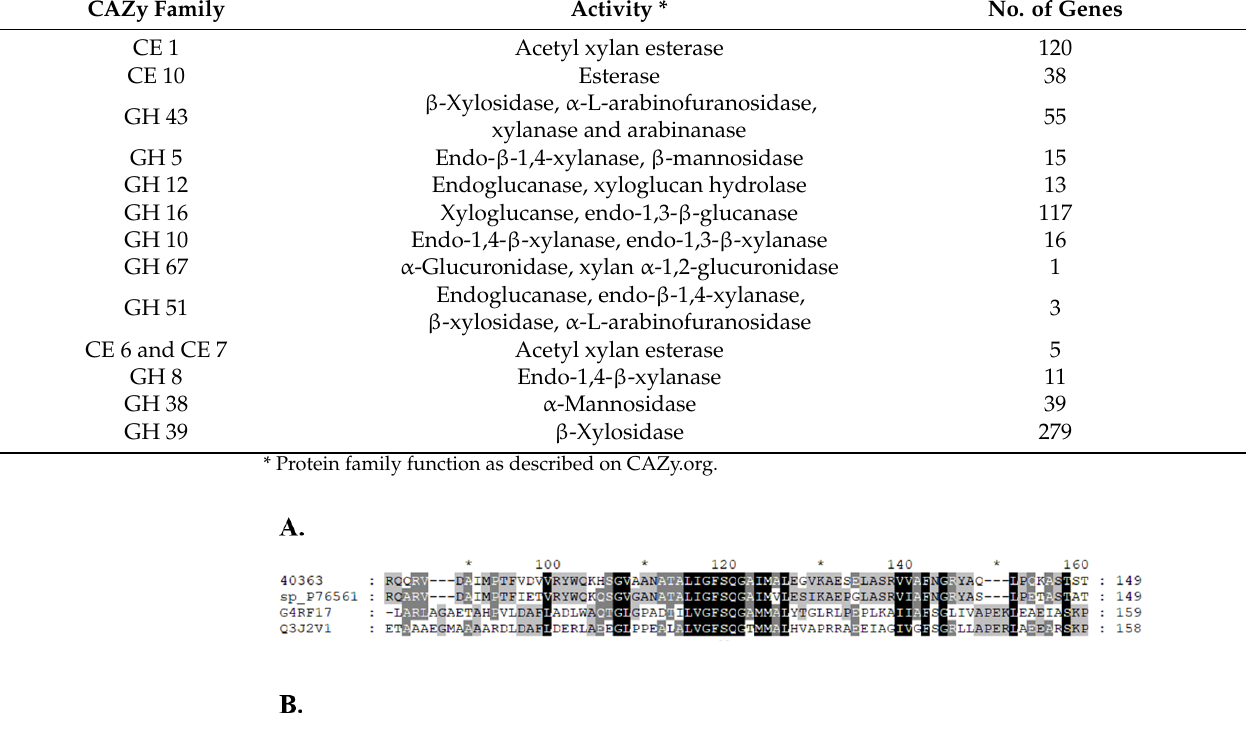
Table 1. Hemicellulases screened from the metagenomic library of the slug’s gut microbiota. CAZy Family